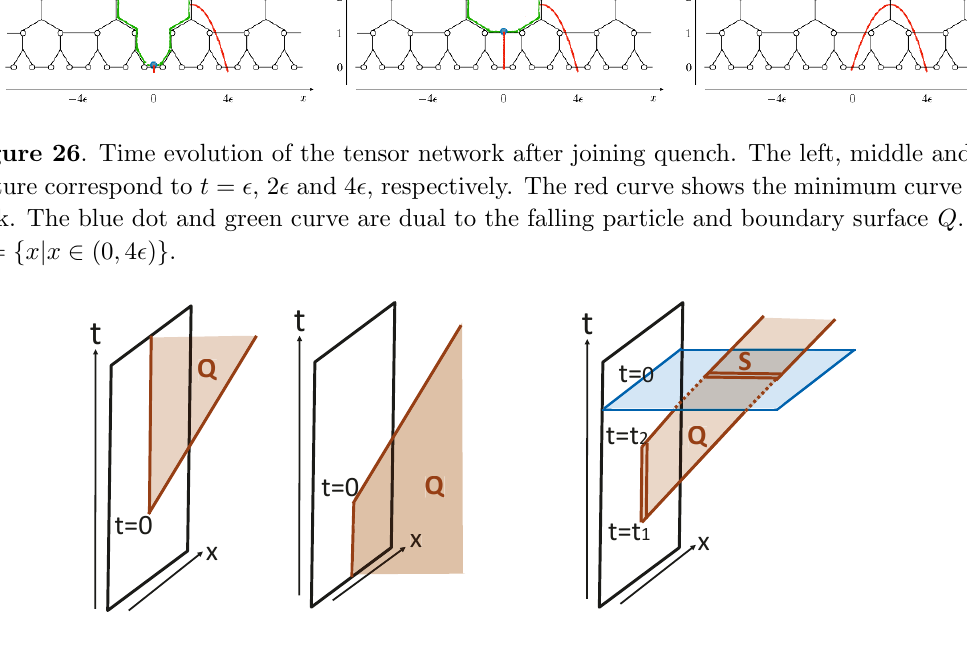
Figure 27 . A simpli(cid:12)ed sketch of the gravity dual spacetimes for the splitting (left), the joining (middle) local quench and their combination (right). The brown surfaces describe the boundary surfaces Q . In the right picture, the boundary surface Q intersects with the blue horizontal plane which describes the time slice t = 0. Their intersection S makes a slit on the time